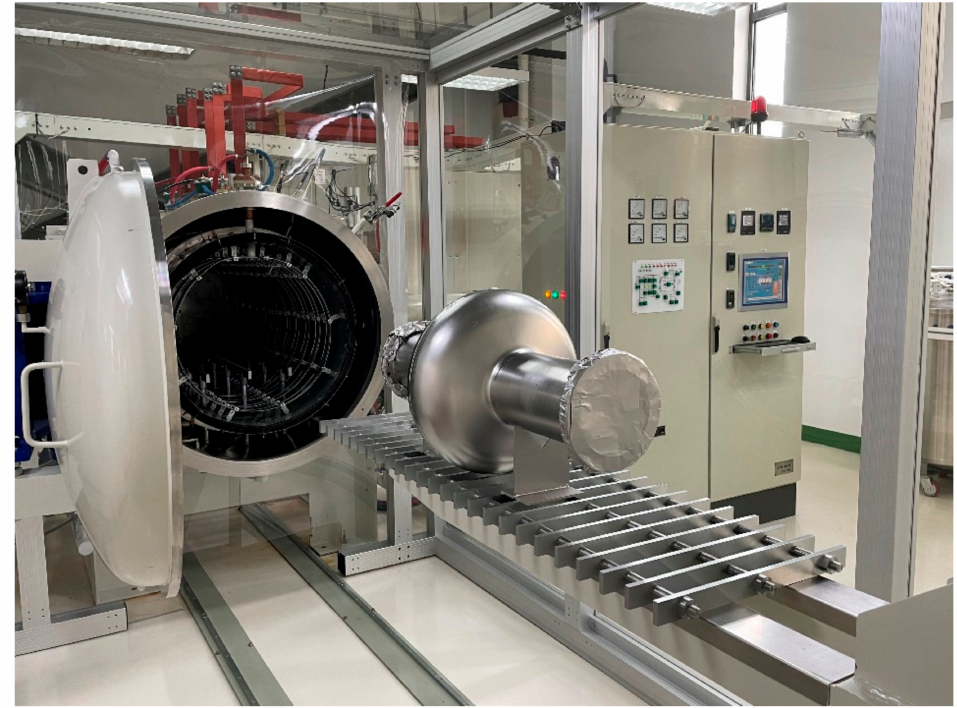
Figure 3. Setup of the mid-T furnace baking for 650 MHz